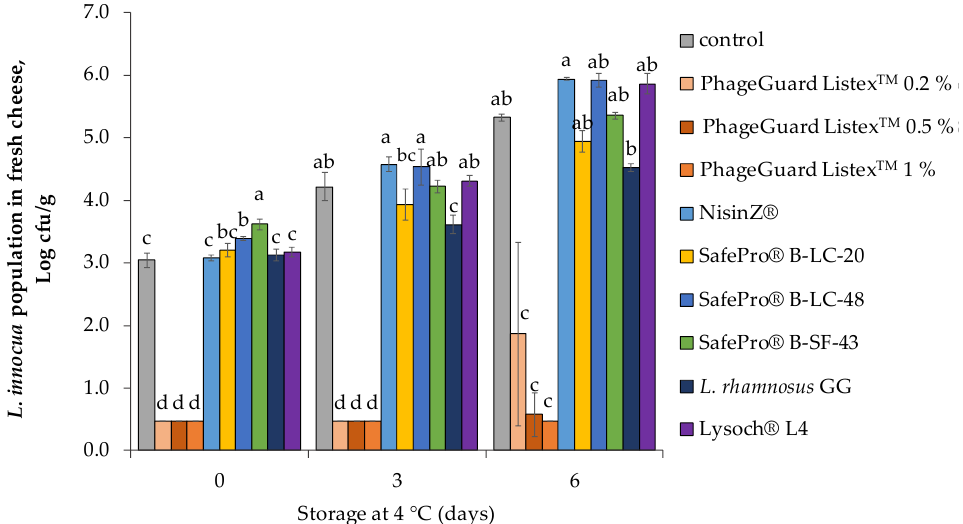
Figure 3. Effect of the biopreservative treatments on L. innocua population in fresh cheese throughout storage at 4 °C. Values are means ± standard deviations of three biological replicates. Bars marked with different letters (a, b, c and d) represent statistically significant differences among treatments ( p < 0.05) at each sampling time.